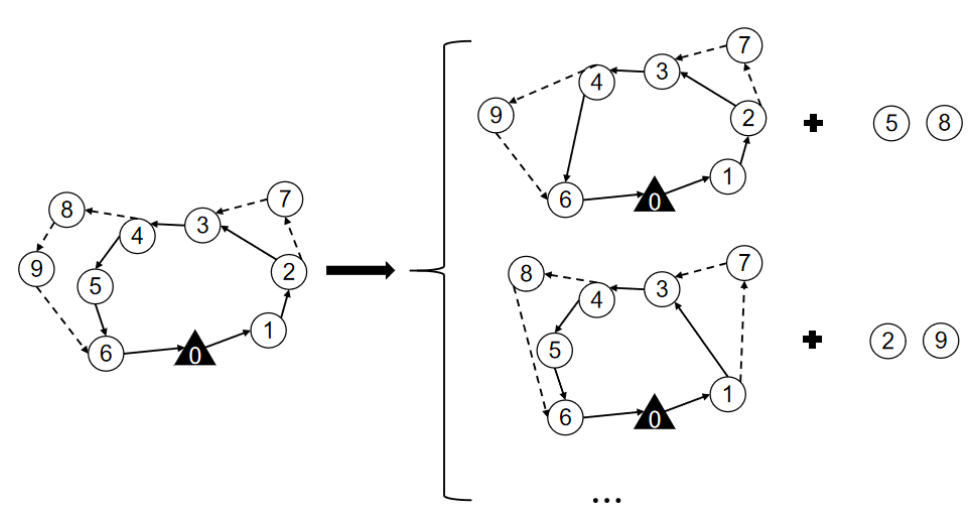
Figure 5. Schematic diagram of the random destroy operator when q = 2.